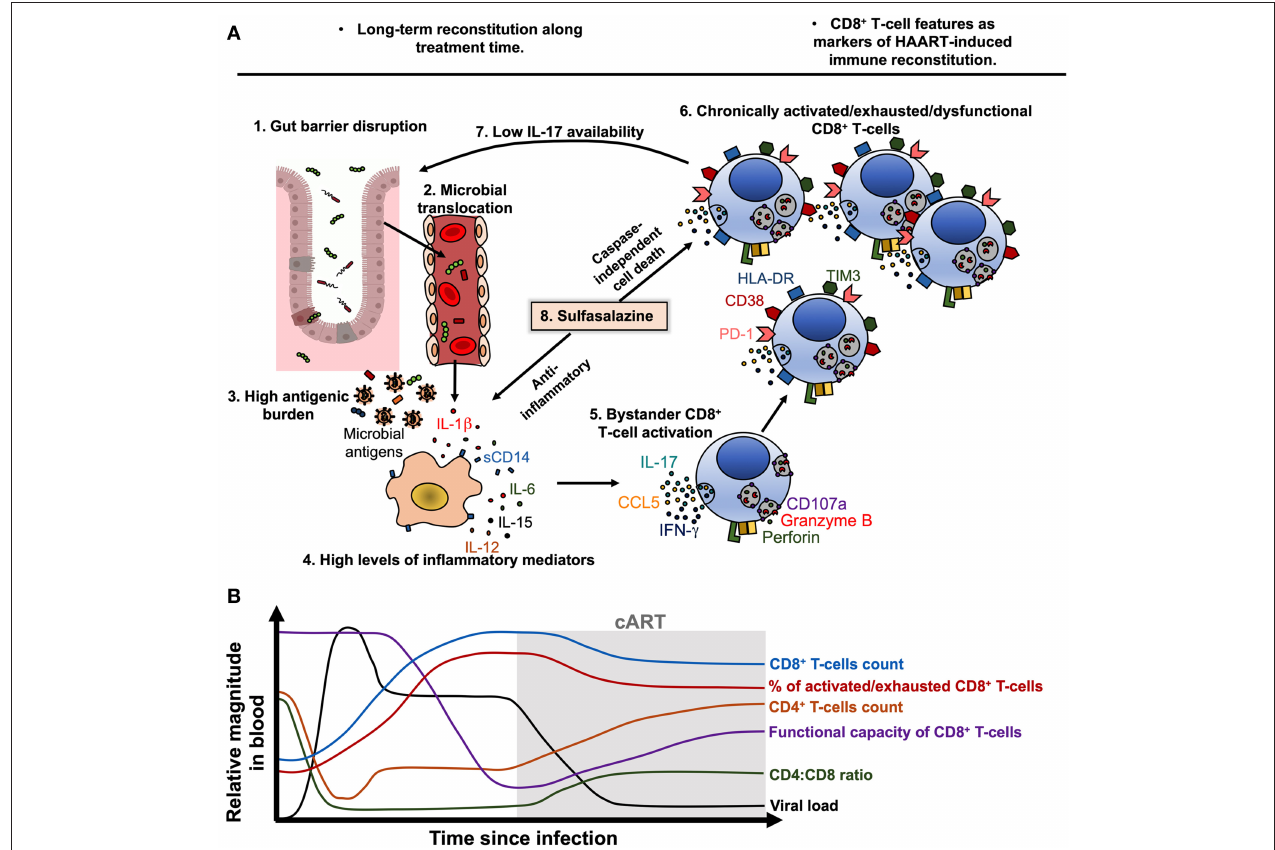
FIGURE 2 | Model of CD8 + T-cell activation, exhaustion and dysfunction during treated HIV infection. (A) During chronic HIV, and despite cART-induced viral suppression, gut barrier disruption (1) causes the passage of microbial products to systemic circulation (microbial translocation, 2), contributing to a high antigenic burden together with residual HIV replication and ongoing co-infections (3). Microbial products and other antigens activate innate immune cells such as monocytes/macrophages, which activate and release soluble CD14 (sCD14) and inflammatory cytokines such as IL-1 β , IL-6, IL-15, and IL-12 (4). Particularly, IL-15 and IL-12 induce bystander activation of CD8 + T-cells (5), which in early stages of disease may exhibit potent cytotoxic capacity and cytokine production. Nonetheless, chronic bystander stimulation induces exhaustion and dysfunction of CD8 + T-cells (6), which have an increased expression of HLA-DR, CD38, PD-1 and TIM3, and lower degranulation capacity and IL-17 secretion, among other alterations. The low secretion of IL-17 causes a low availability of this cytokine and its beneficial effects on gut mucosa, worsening the gut barrier disruption (7). In this setting, sulfasalazine could be a therapeutic approach to target the inflammatory environment and activated/dysfunctional CD8 + T-cells, through the inhibition of inflammatory cytokine secretion and induction of caspase-independent cell death (8). (B) Model of the dynamic of viral load, CD4 + T-cells count, CD8 + T-cells count, CD4:CD8 ratio, the frequency of activated/exhausted CD8 + T-cells and their functional capacity in HIV-infected patients before and after ART beginning. Of note, the viral load is efficiently suppressed and the CD4 + T-cells count are recovered after treatment beginning, but the CD8 + T-cells features remain disturbed despite